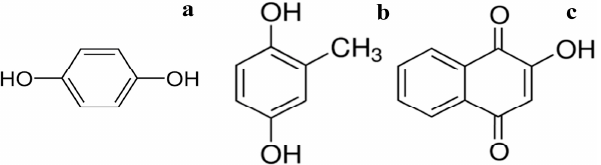
Figure 1. Quinone centers incorporated into the humic compounds (HC) used in this study: HQ ( a ), MeHQ ( b ), NQ ( c ).